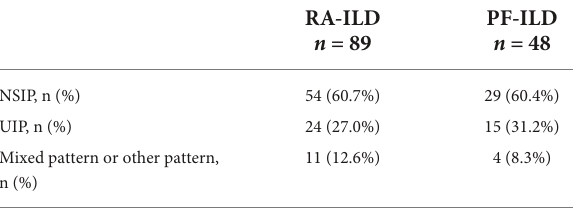
RA-ILD PF-ILD n = 89 n = 48 11 (12.6%) 4